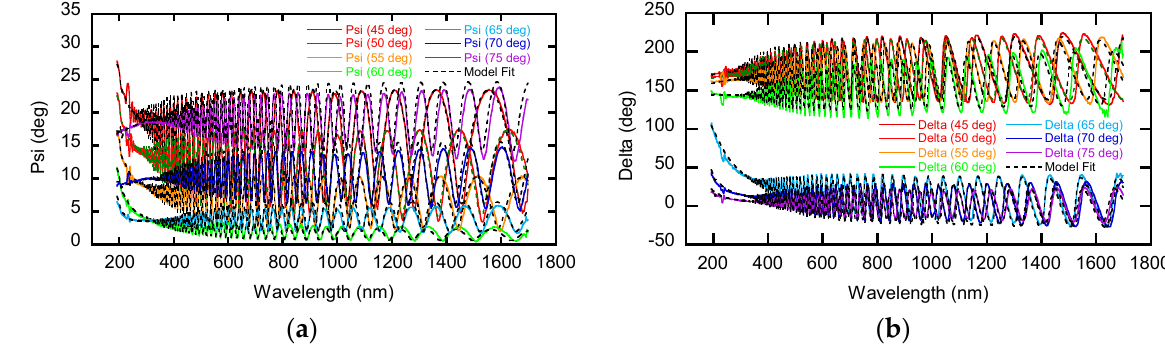
Figure 11. Experimental SE spectra of ( a ) Ψ and ( b ) Δ , and fitting spectra (dashed line).